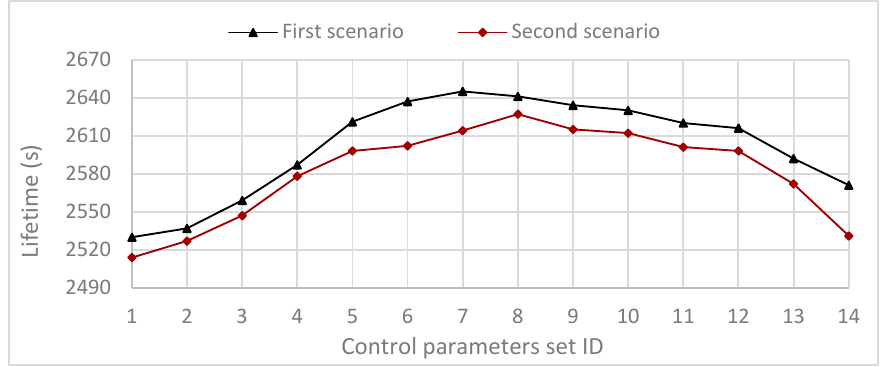
Figure 7. Impact of control parameters sets on the network lifetime for first scenario and second scenario.